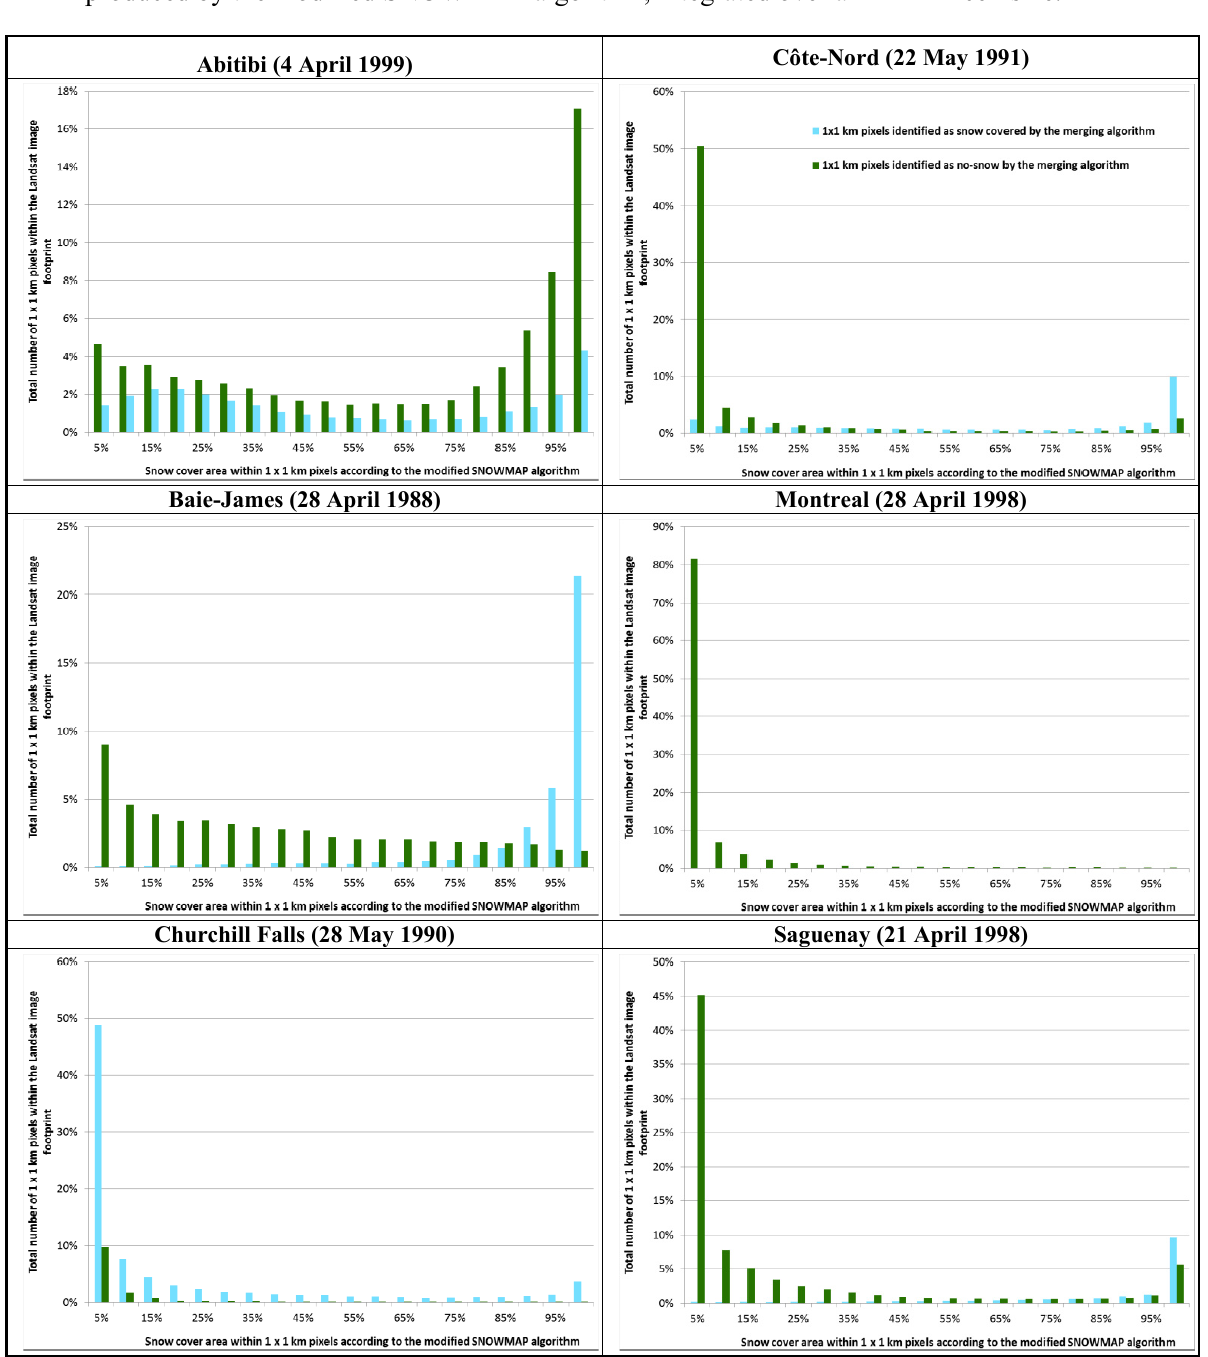
Figure 7. Snow detection by the merging algorithm, compared to the snow cover fraction produced by the modified SNOWMAP algorithm, integrated over a 1 × 1 km cell